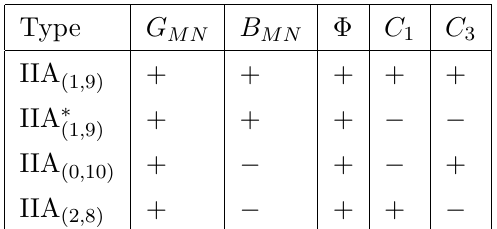
Table 6 . Relative signs for kinetic terms in ten-dimensional type-IIA theories. A + sign corresponds to a standard kinetic term in Lorentz signature, thus discarding the overall − sign with which these terms appear in the action when using the mostly plus convention for the metric.